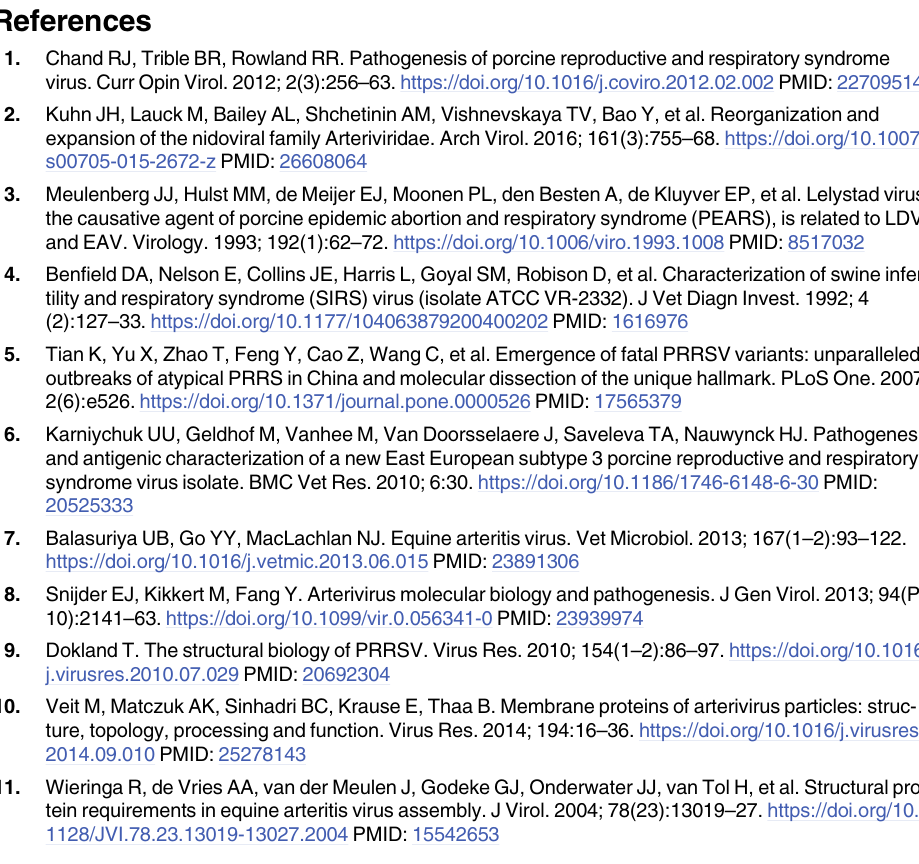
2332 strain. 20 hours after transfection cells were lysed and digested with Endo-H or left untreated as indicated. Samples were subjected to SDS-PAGE and western-blotting with anti- HA or anti-His antibodies. S4 Fig. Infection of MARC cells and PAMs with wild-type PRRSV and acylation deficient GP5 mutants. 1x10 5 Marc cells or 4x10 6 PAMs were infected with 1x10 5 virus particles as determined by qRT-PCR. 10 hours after infection cells were fixed, and stained with mouse anti-N antibody followed by anti-mouse IgG antibody coupled to Alexa 568. Pictures were recorded using a ZEISS Axio Vert. A1 inverse epifluorescence